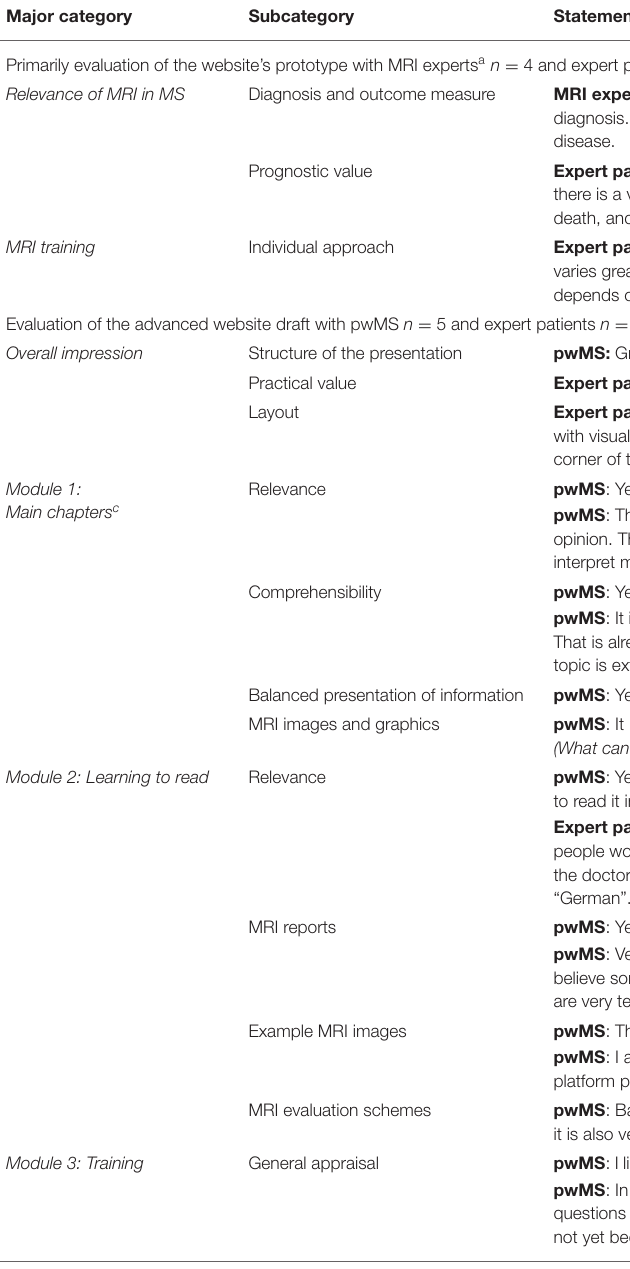
TABLE 1 | Quotes from audiotaped interviews divided into different (sub-) categories. Major